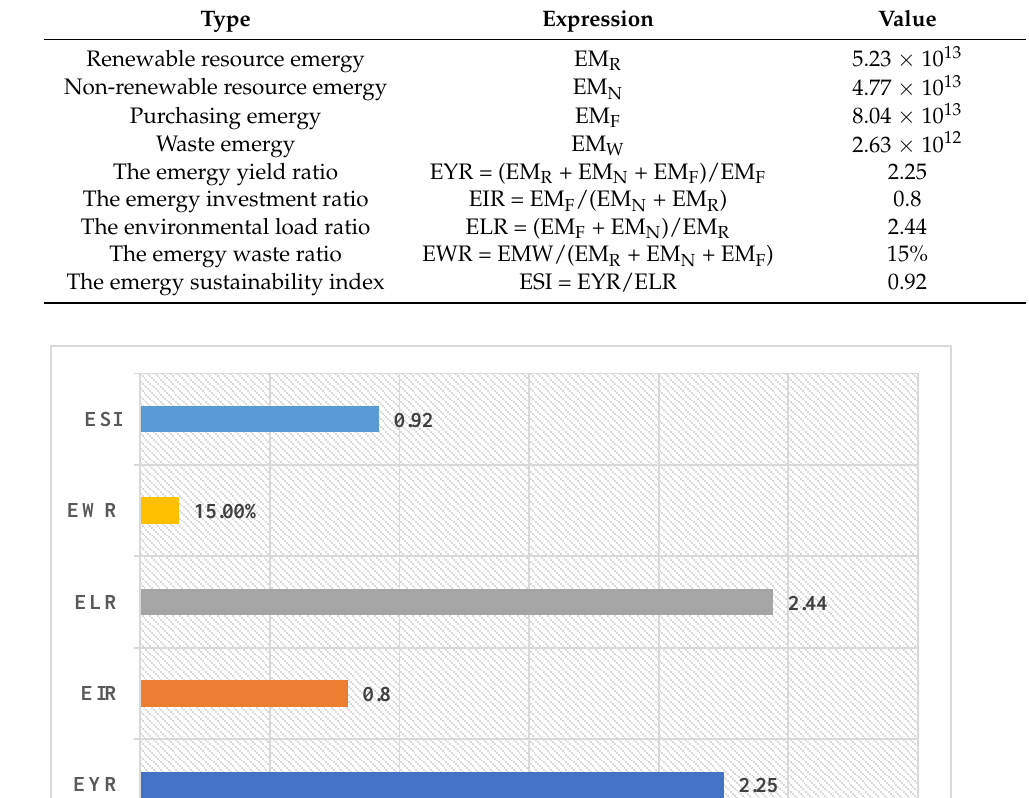
Table 3. Various emergy flows and results.